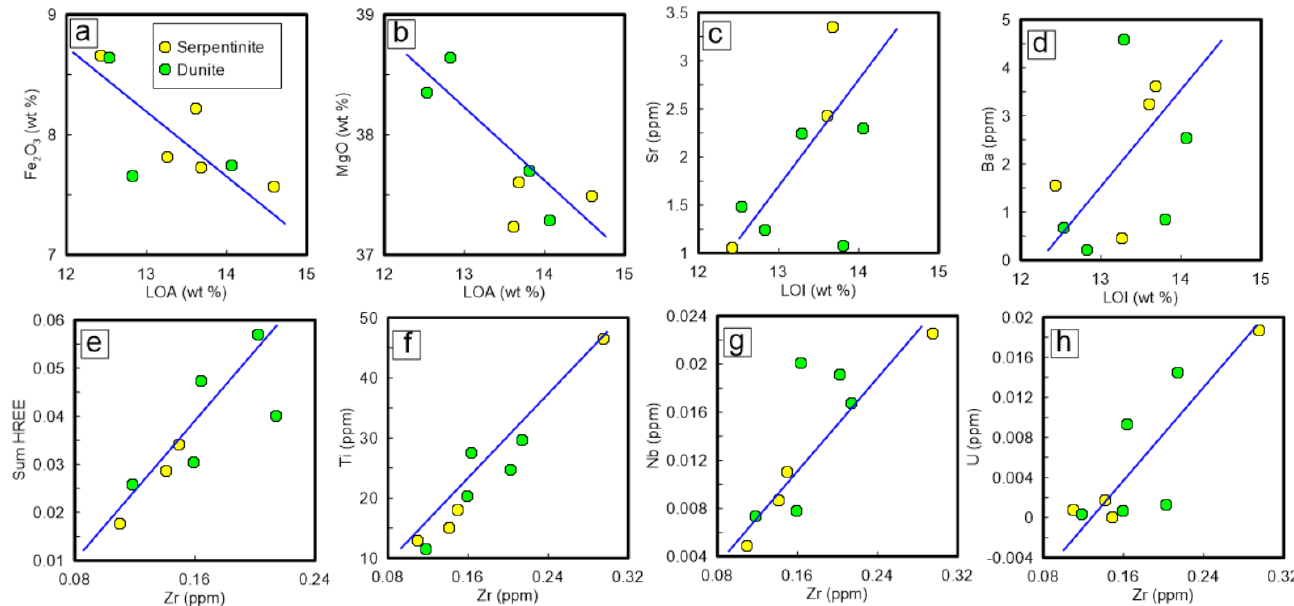
Figure 10. Binary plots showing variations in selected major and trace elements against LOI and Zr for the investigated WOC peridotites.